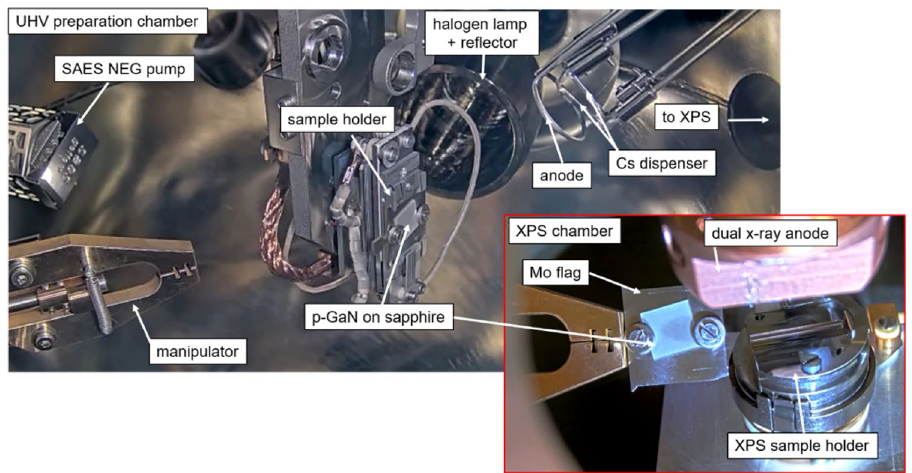
Figure 11. The interior of the UHV preparation chamber (showing a sample holder, a halogen lamp with reflector, a steel ring anode, and Cs dispensers) and the XPS analysis chamber connected to the preparation